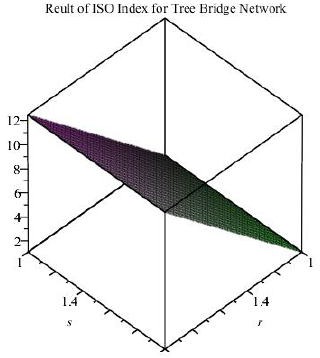
Figure 2. Result of ISO index for bridge networks of trees.